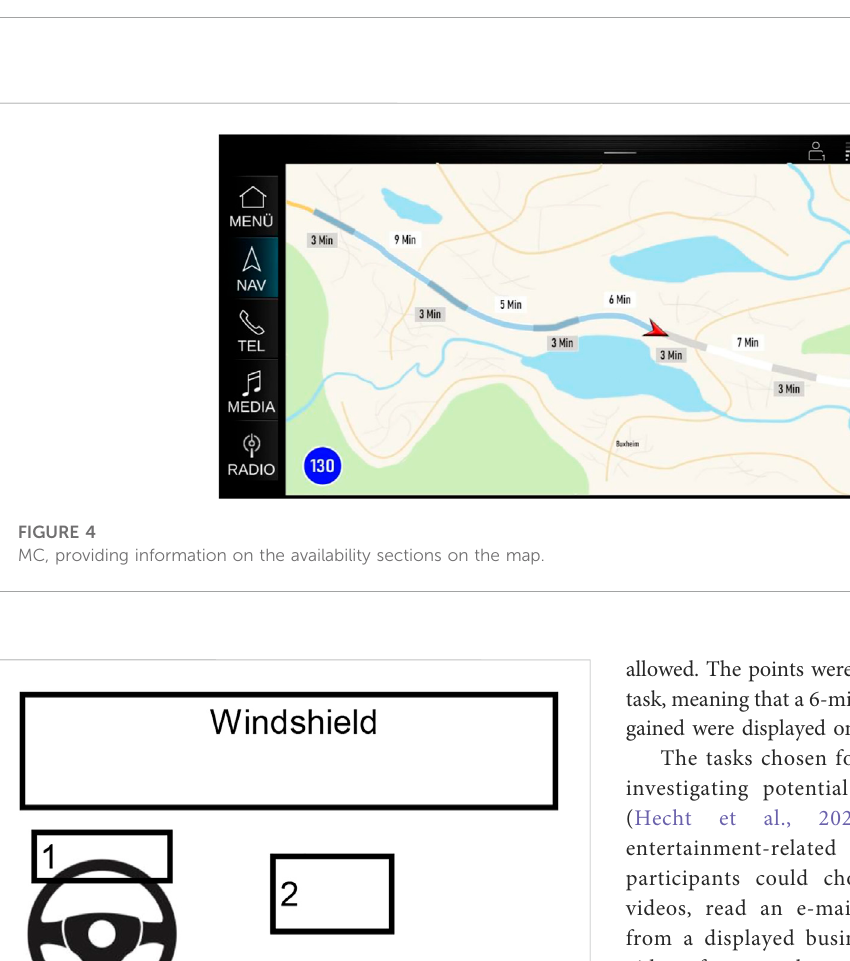
FIGURE 3 AC, providing information on the availability sections in an abstract time bar.